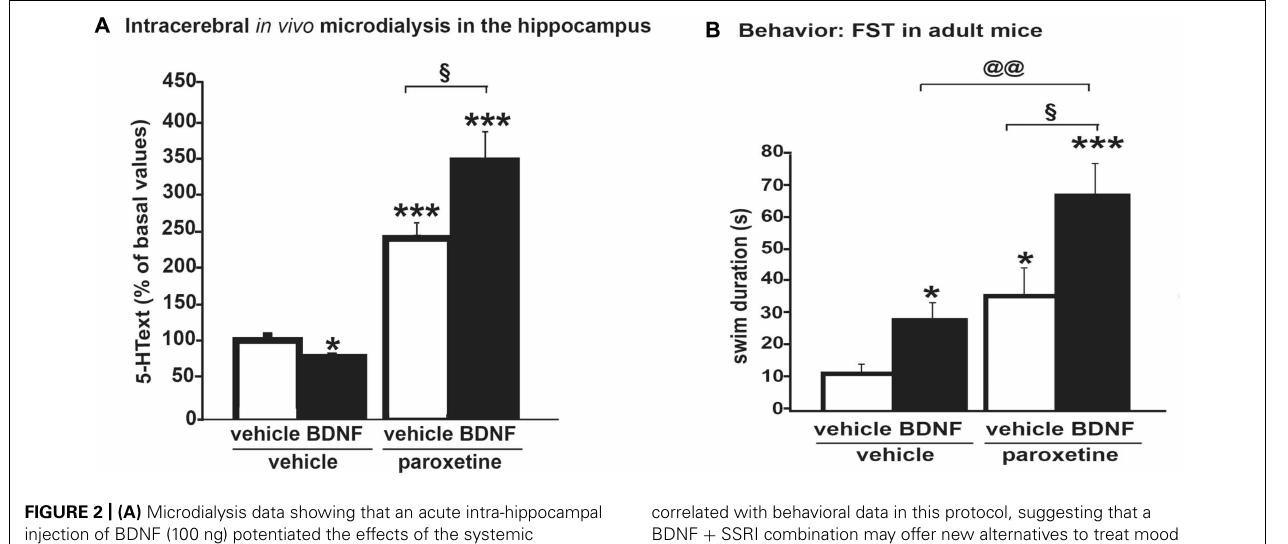
FIGURE 2 | (A) Microdialysis data showing that an acute intra-hippocampal injection of BDNF (100 ng) potentiated the effects of the systemic administration of an SSRI, paroxetine (4 mg/kg; i.p.) on dialysate 5-HText in the hippocampus of freely moving wild-type mice. Results are expressed as AUC values (means ± SEM) calculated for the amount of 5-HText collected during the 0–120 min post-treatment period. (B) Antidepressant-like activity of paroxetine as measured on swimming behavior in the forced swim test (FST) was potentiated by BDNF.Thus, neurochemical changes